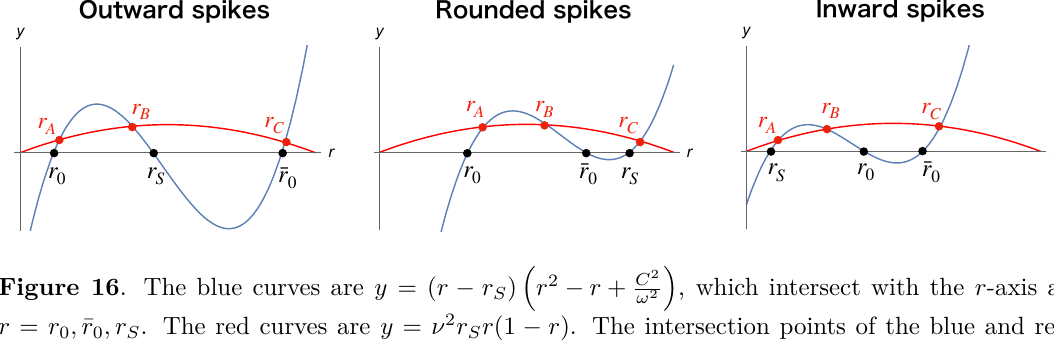
(cid:16) (cid:17) , which intersect with the r -axis at Figure 16 . The blue curves are y = ( r − r S ) r 2 − r + C 2 ω 2 r = r 0 , ¯ r 0 , r S . The red curves are y = ν 2 r S r (1 − r ) . The intersection points of the blue and red curves are the three solutions r of eq. (A.10). In the limit ν → 0 , the three solutions approach A,B,C to r ¯ r , and the solutions in section 4 are reproduced. For example, when r ¯ r , finite 0 , 0 , r S 0 < r S < 0 ν solutions with r A < r B < r S < r C are reduced to the outward spike